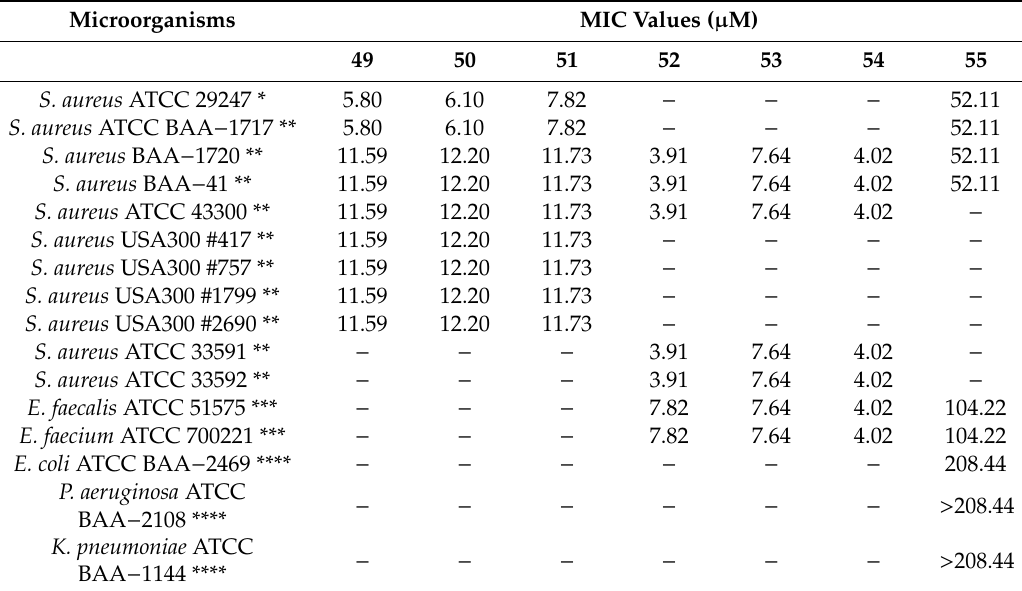
Table 10. MIC values of the pyrimidine analogues on drug-resistant